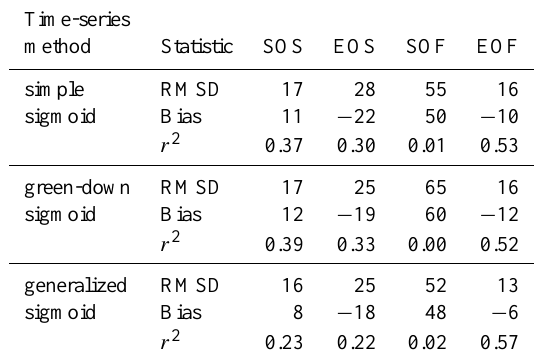
Table 7. Statistics comparing the MODIS phenology product to near-surface imagery. Statistics computed as in Table